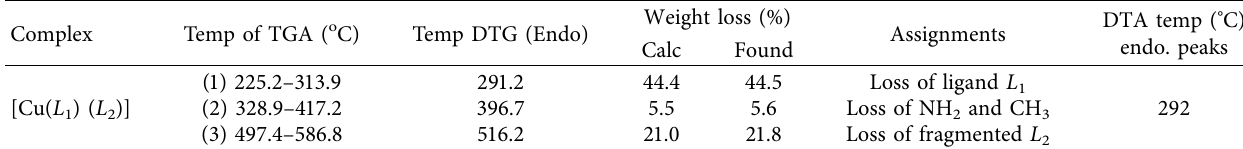
Table 1: Thermogravimetric analytical data of the